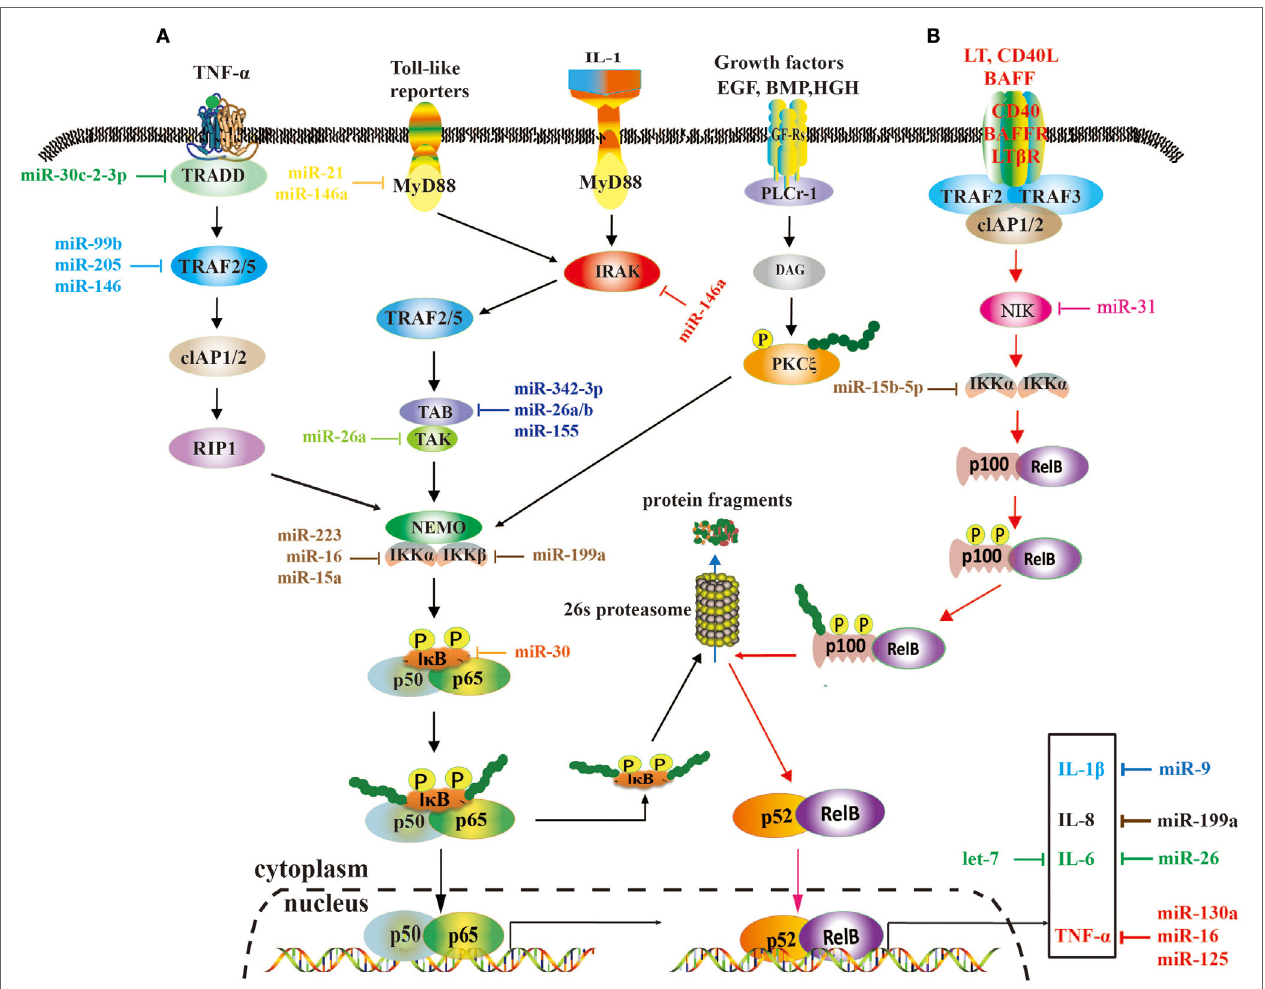
FigURe 2 | A role of microRNAs (miRNAs) in the nuclear factor kappa B (NF- κ B) signaling pathways. These two pathways rely on tumor necrosis factor (TNF), toll-like, interleukin (IL)-1, and EGF receptors (A) , and BAFF reporter and CD40 (B) , respectively, and they are activated or repressed by miRNAs. Activated NF- κ B promotes or restrains the expression of tumor-associated